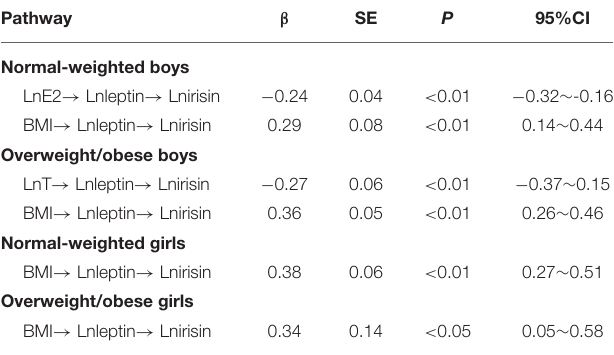
TABLE 3 | Bootstrap analysis of significance test of indirect